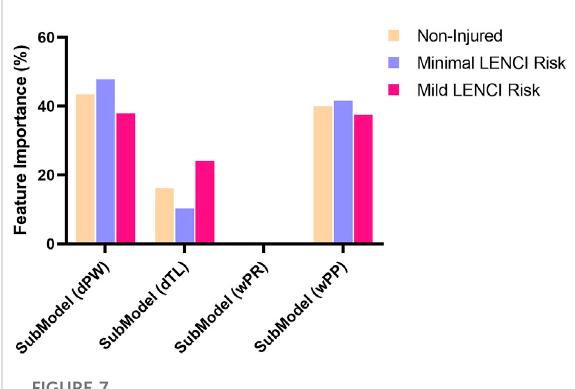
FIGURE 7 The feature importance of the dFusionModel.